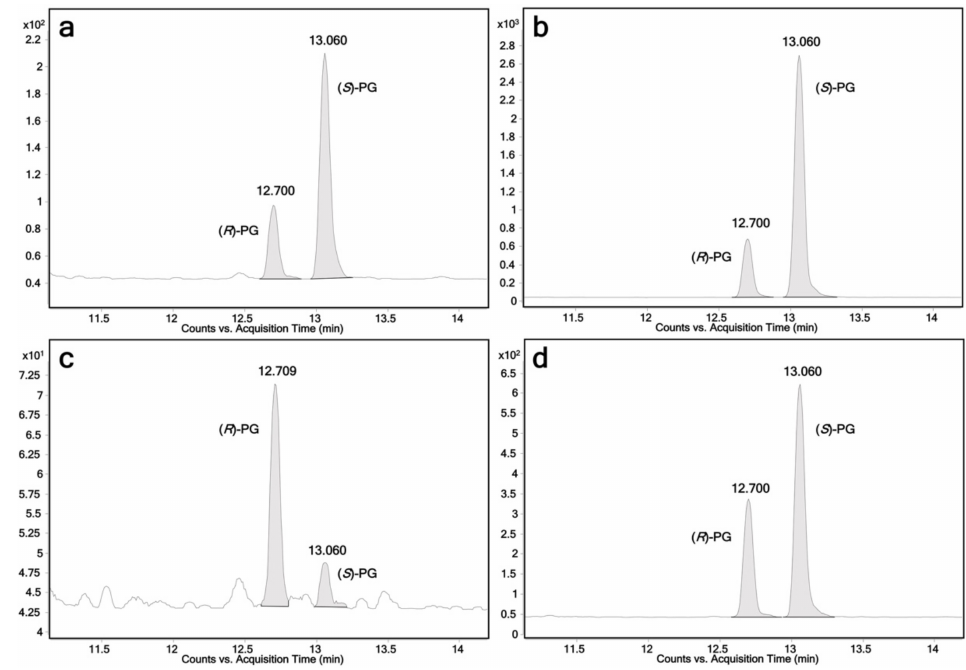
Figure 1. Chromatograms of ( R )-propranolol glucuronide and ( S )-propranolol glucuronide ob- tained from individual UGT reactions using racemic propranolol as the substrate. Ion transition m / z 436 → 116 is monitored; ( R )-PG: ( R )-propranolol glucuronide, retention time 12.7 min; ( S )-PG: ( S )-propranolol glucuronide, retention time 13.1 min; ( a ) UGT1A7; ( b ) UGT1A9; ( c ) UGT1A10; ( d ) UGT2A1.